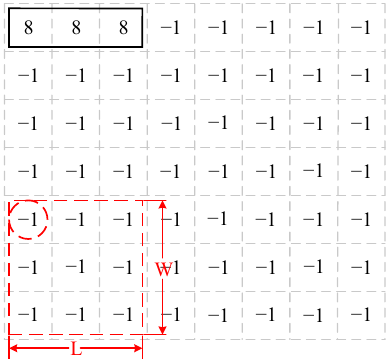
Figure 5. Schematic diagram of the next node fi ltering. Algorithm 2. Next chiplet selection